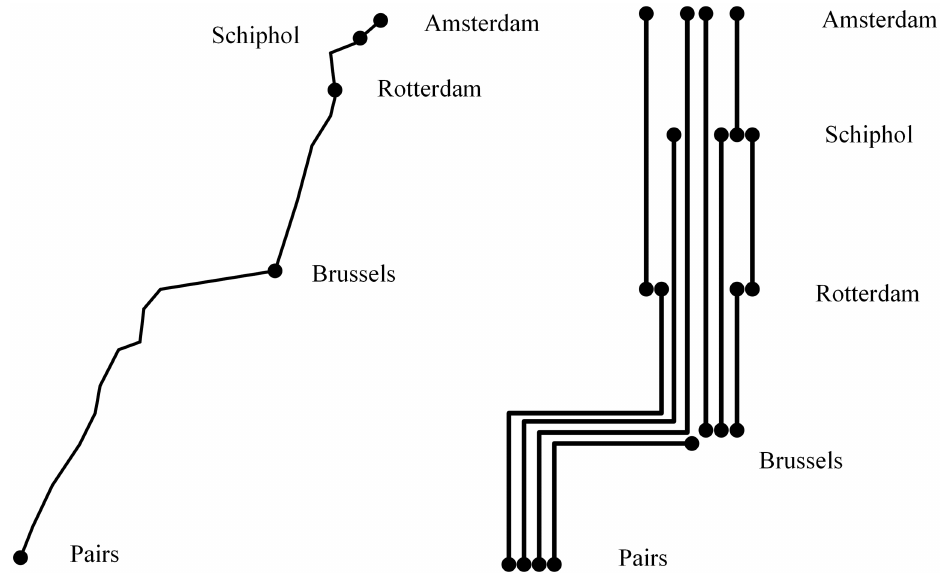
Fig 8. A map of Thalys high-speed railway.